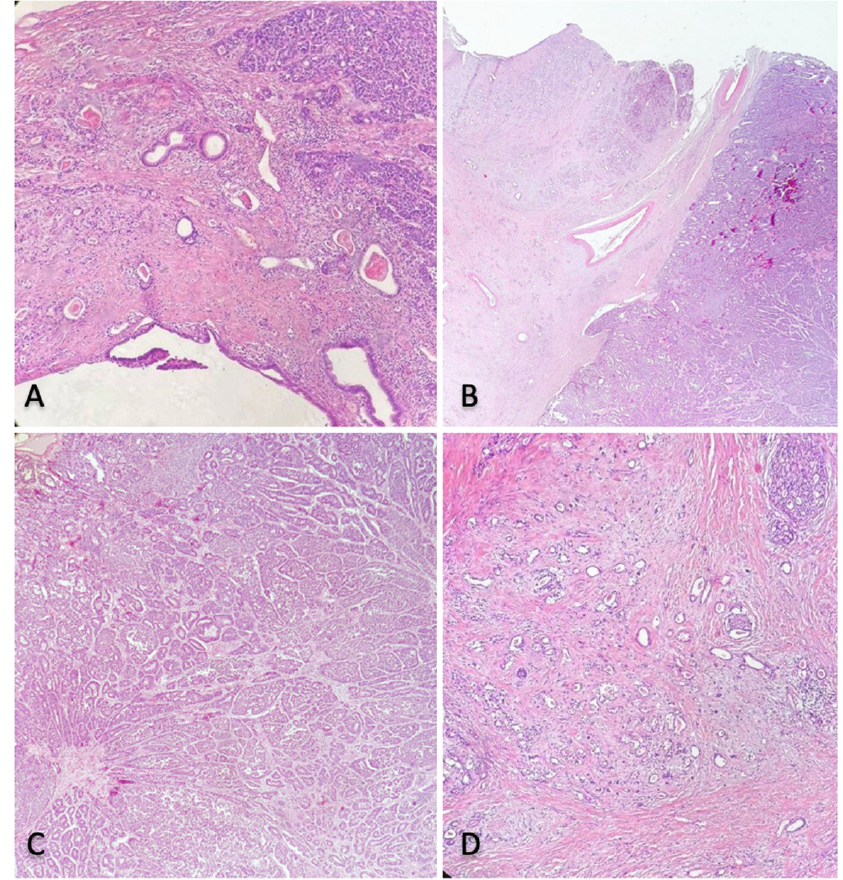
Figure 2. ( A , B ) MiNEN consisting of a neuroendocrine component (both of the left side of the images) and non-neuroendocrine component (ductal adenocarcinoma) (both on the right side of the images), each one accounting for more than 30% of the tumour. ( C ) Neuroendocrine component; ( D ) Non neuroendocrine, ductal adenocarcinoma component.